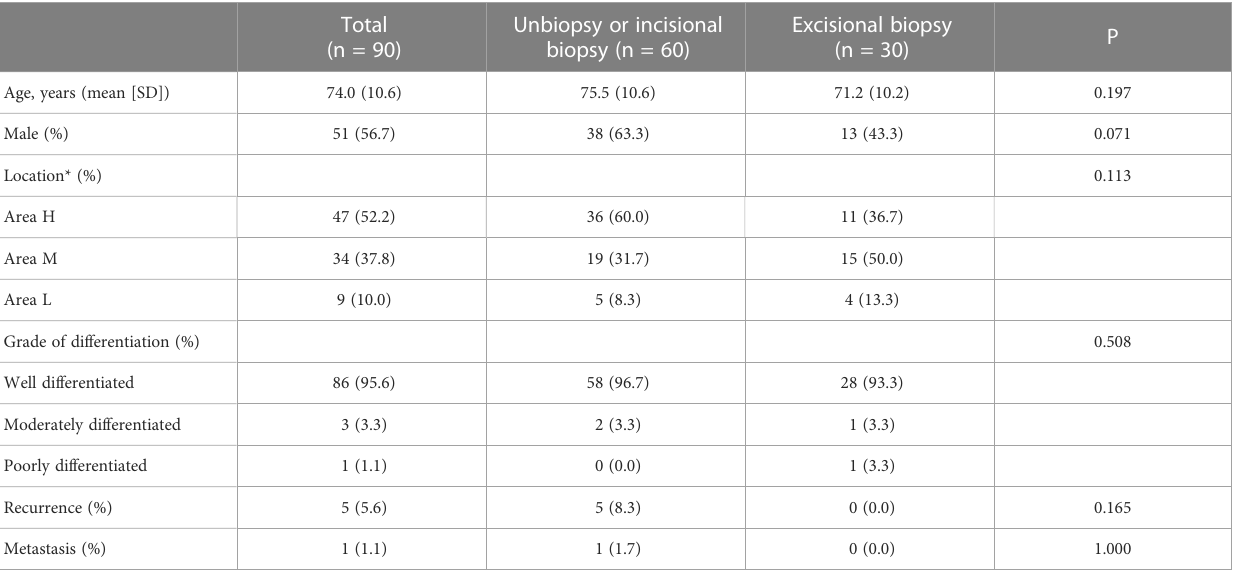
TABLE 1 Demographics and tumor